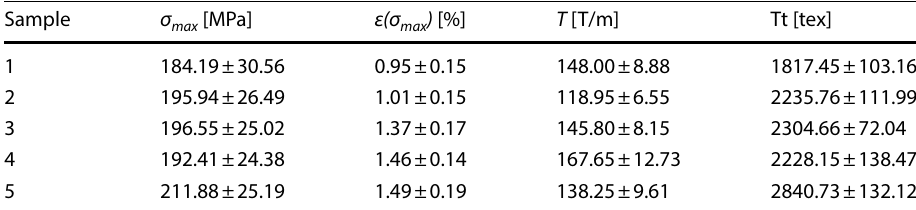
Table 7 Properties of samples